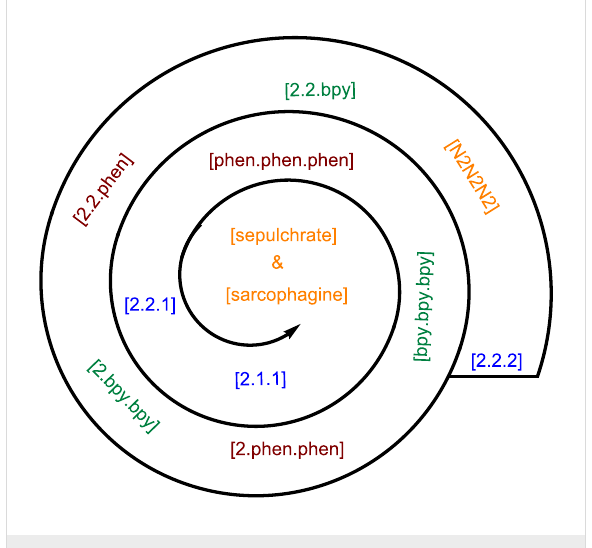
Figure 17: Trend in the preferred ion selectivity of the studied cryptands. Every cryptand family is distinguished by a different color.